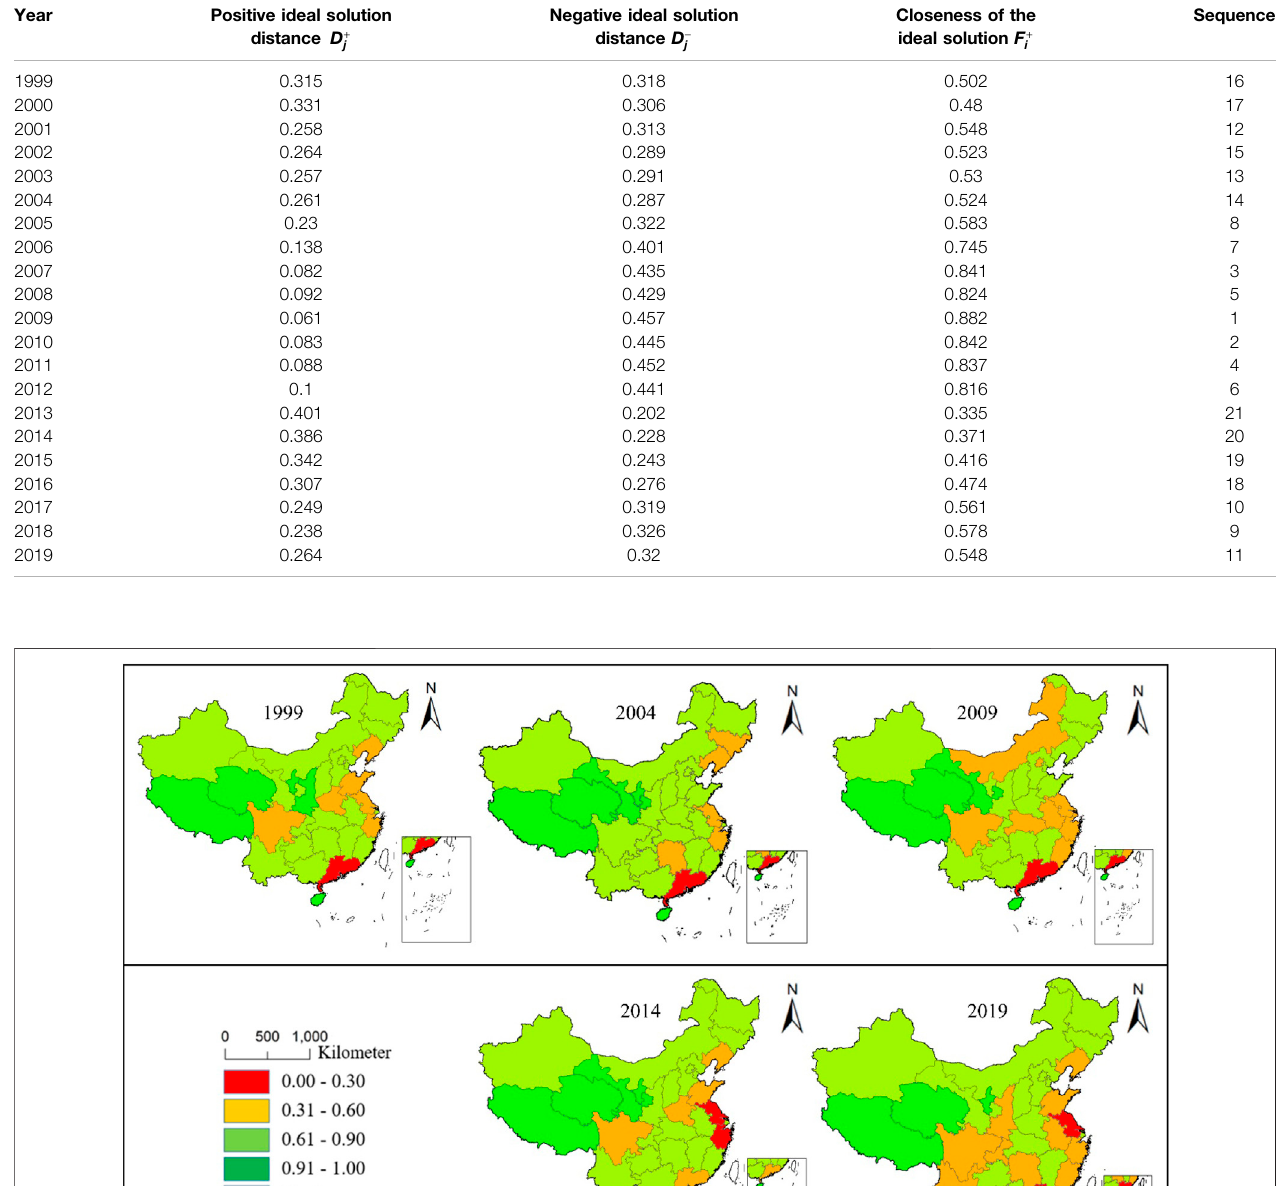
TABLE 6 | Fire situation evaluation results in China from 1999 to 2019. Year Positive ideal solution